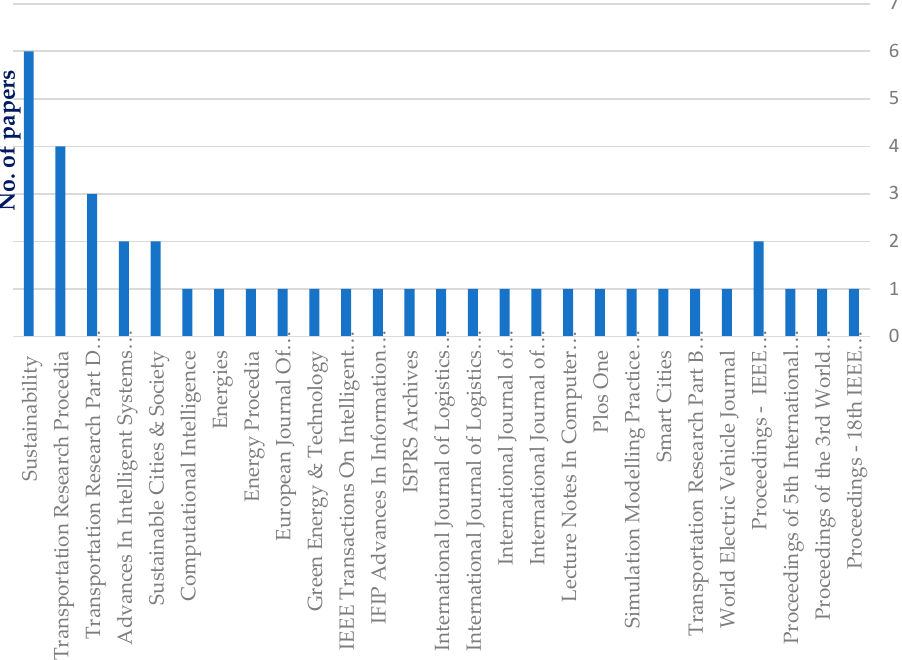
Figure 6. Distribution of papers by